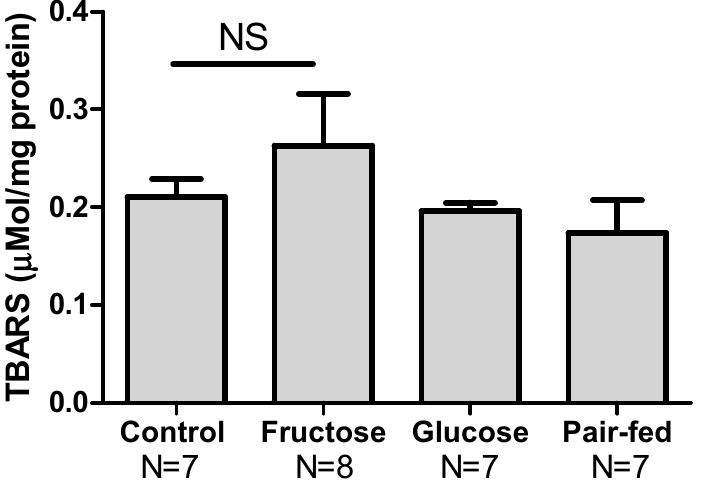
Figure 5. Results of thiobarbituric acid reactive substances (TBARS) assays shows that fructose and glucose feeding do not result in significant increases in hepatic lipid peroxidation. Data was analyzed via one-way ANOVA ( p =